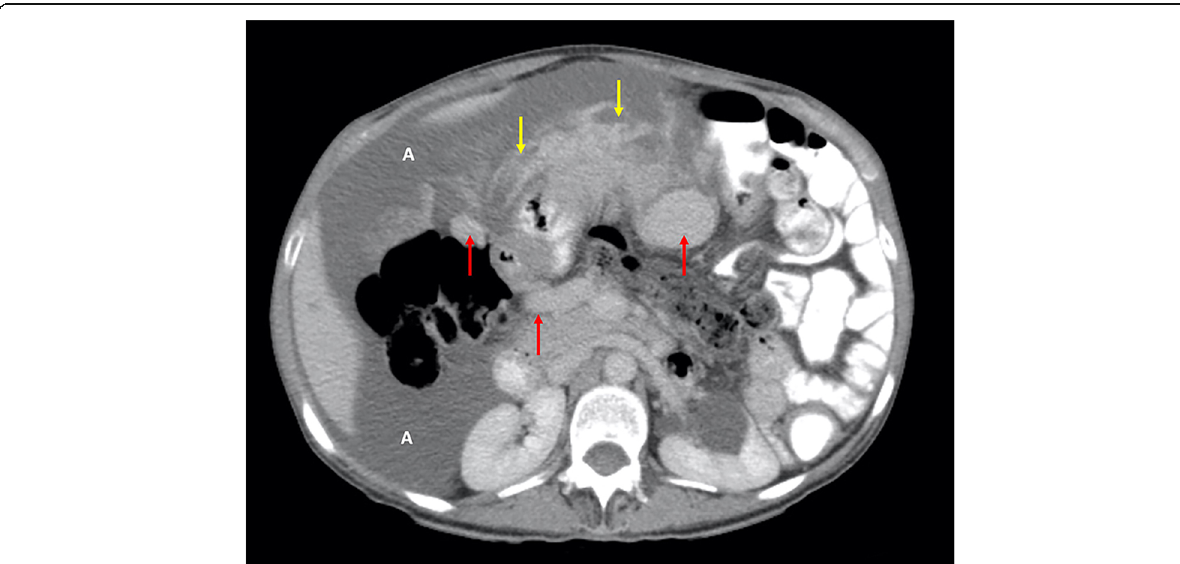
Fig. 2 Axial post-contrast MDCT image at the level of the upper abdomen, depicting the enlarged vessels (red arrows) converging to the superior mesenteric vein. Note all the surrounding structures (particularly the kidneys and the jejunum) compressed by the tumour (yellow arrows). Some intraperitoneal fluid (A) is also